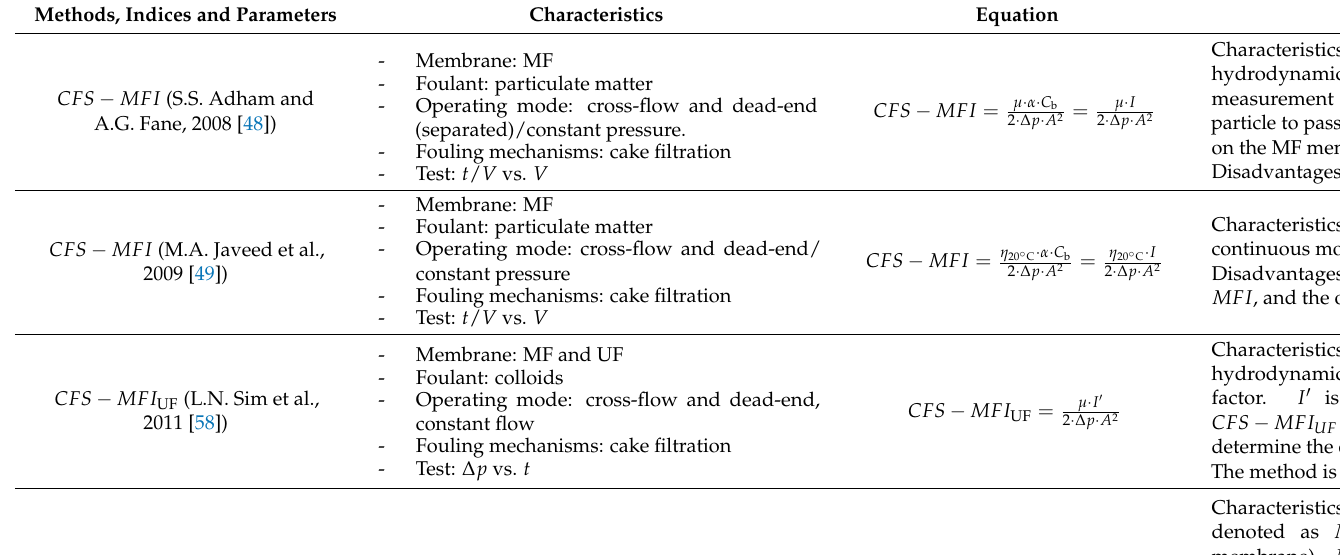
Methods, Indices and Parameters Characteristics Equation